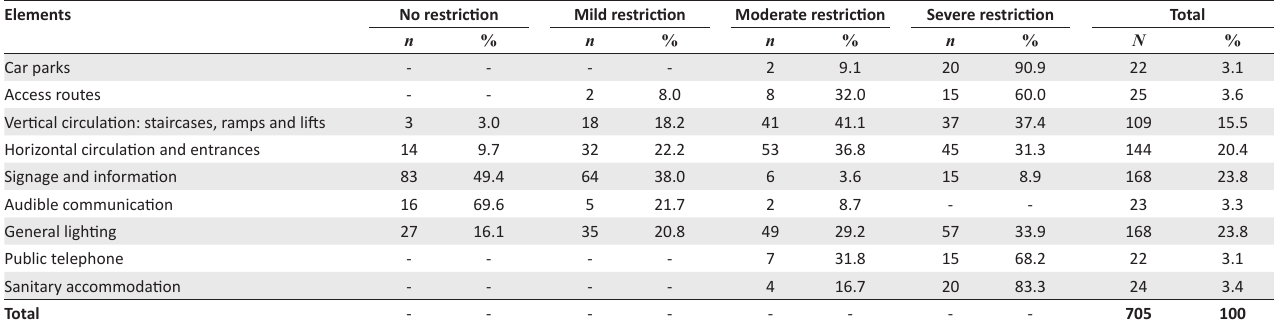
TABLE 5: Level of compliance of elements in relation to international instruments. Elements No restriction Mild